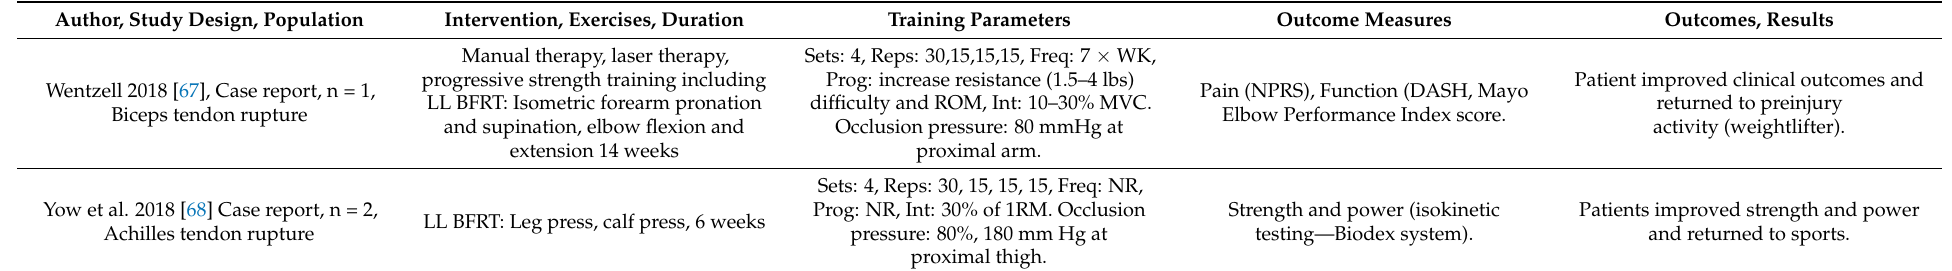
Table 3. Studies on BFRT in tendon rupture rehabilitation.